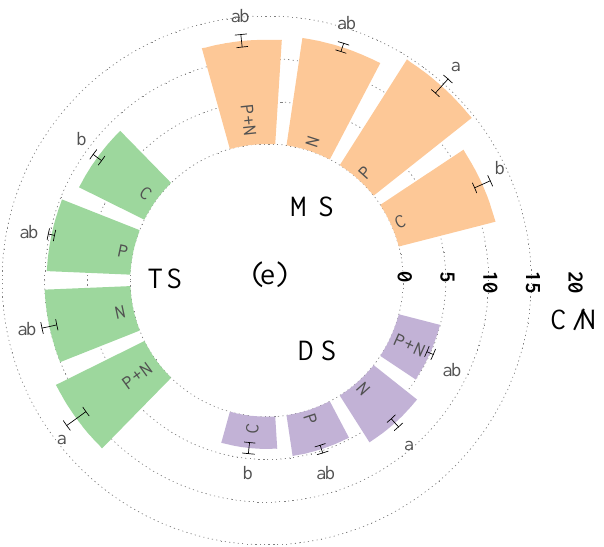
Figure 3. Effects of plowing and nutrient addition on soil basic properties. ( a ) Soil pH; ( b ) soil electrical conductivity (EC); ( c ) soil organic carbon (SOC); ( d ) soil total nitrogen (TN); ( e ) soil C/N ratio. MS: meadow steppe; TS: typical steppe; DS: desert steppe. Different lowercase letters indicate that the same indicator differs significantly among treatments ( p < 0.05).